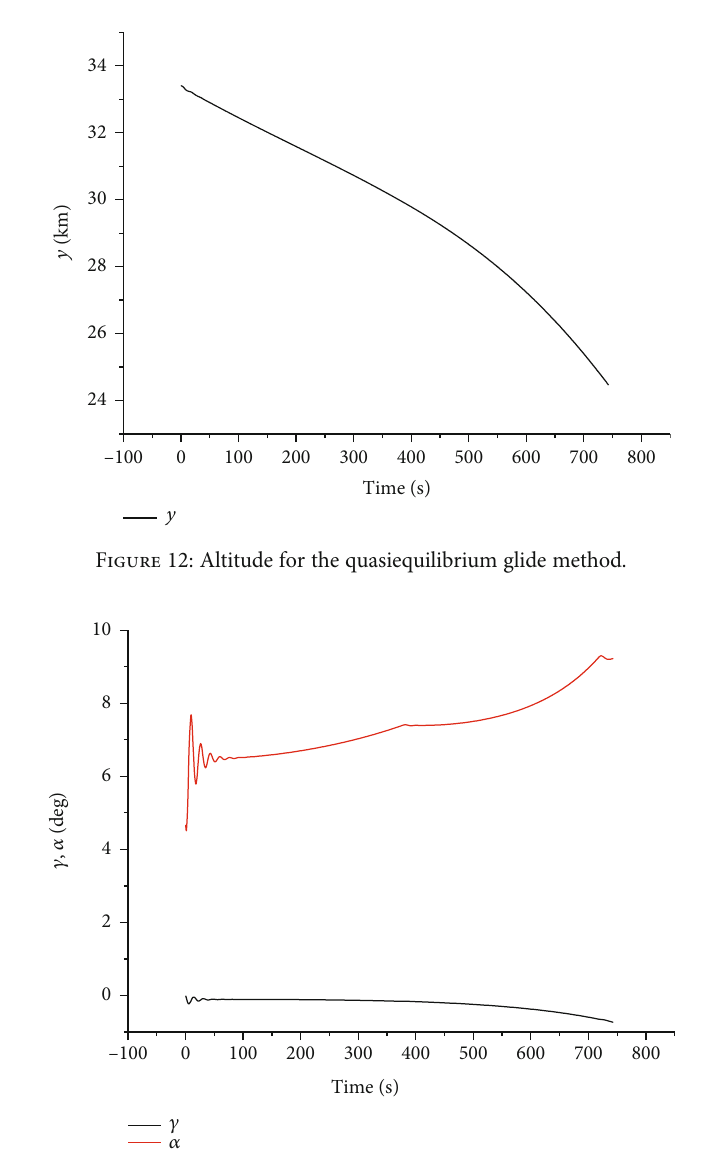
Figure 13: Elevation angle and angle of attack for the quasiequilibrium glide